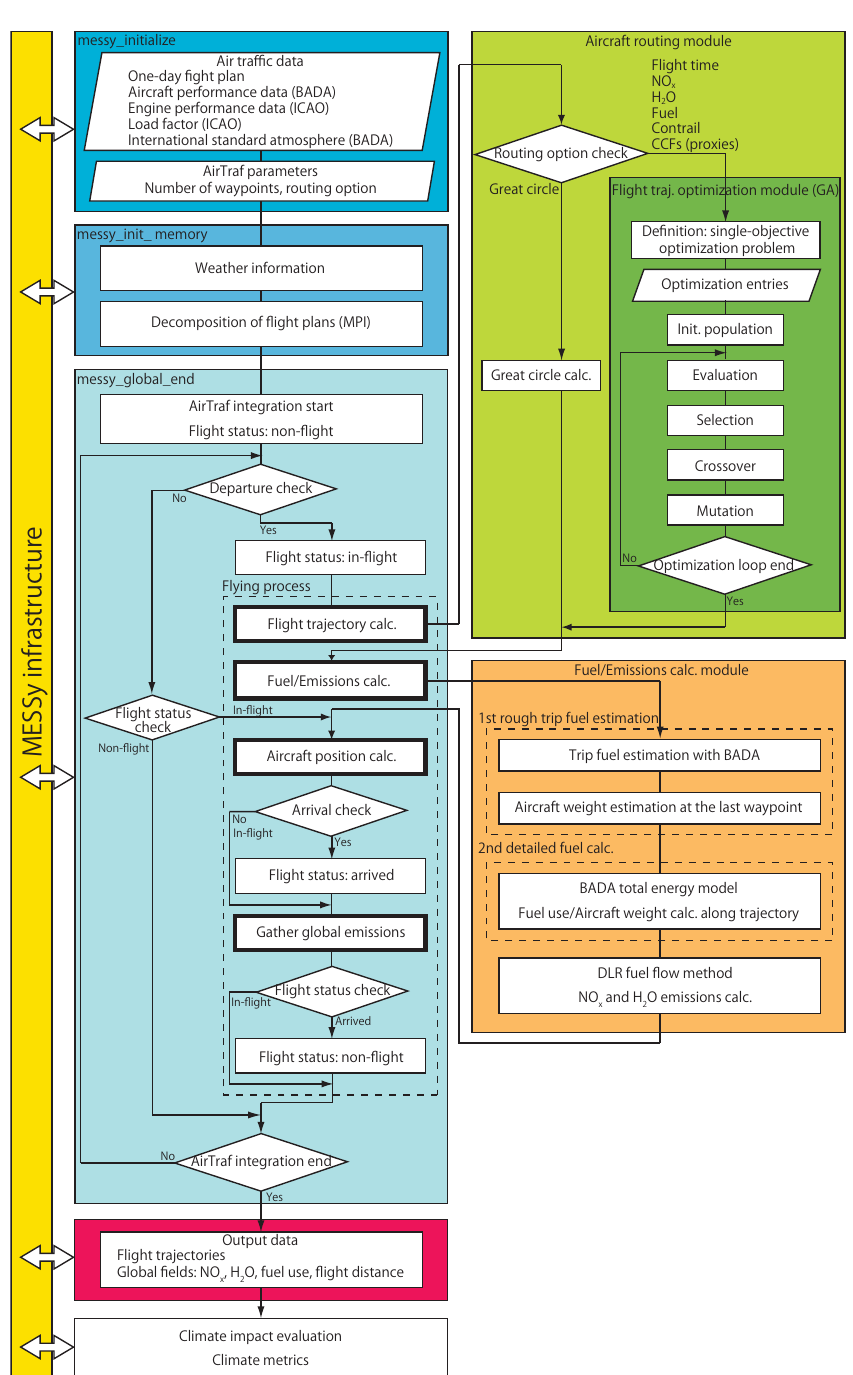
Figure 1. Flowchart of EMAC/AirTraf. MESSy as part of EMAC provides interfaces (yellow) to couple various submodels for data exchange, run control and data input/output. Air traffic data and AirTraf parameters are input in the initialization phase ( messy_initialize , dark blue). AirTraf includes the flying process in messy_global_end (dashed box, light blue), which comprises four main computation procedures (bold-black boxes). The detailed procedures are described in Sect. 2.4 and are illustrated in Fig. 3. AirTraf is linked to three modules: the aircraft routing module (light green), the flight trajectory optimization module (dark green), and the fuel/emissions calculation module (light orange). Resulting flight trajectories and global fields are calculated for output (rose red). Various submodels of EMAC can be linked to evaluate climate impacts on the basis of the